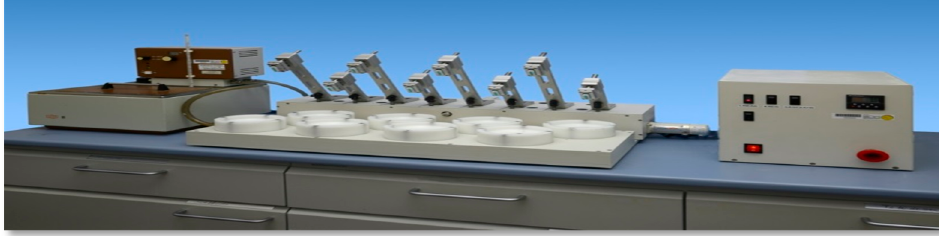
Figure 4. Willytec tooth-brushing simulator for abrasion tests.